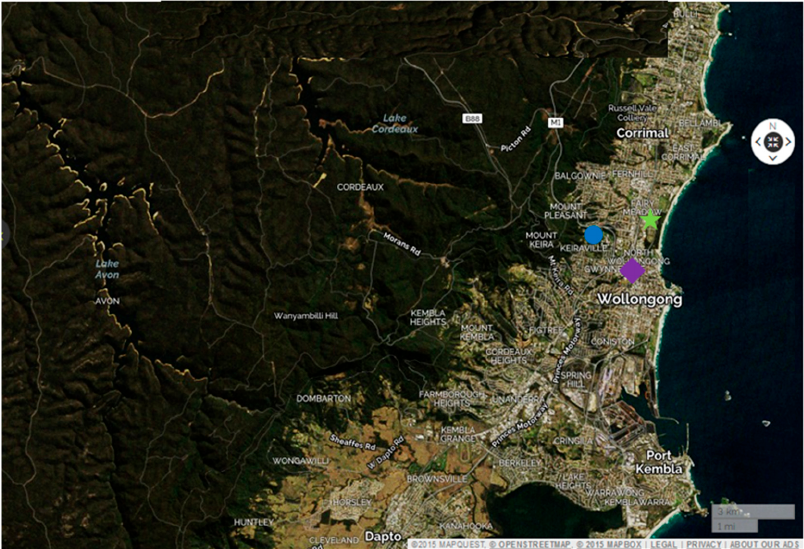
Figure 1. Satellite view of the region showing the main Measurements of Urban, Marine and Biogenic Air (MUMBA) site (green star), Wollongong Office of Environment and Heritage (OEH) Air Quality station (purple diamond) and the University of Wollongong (blue circle). Also visible is the large industrial area at Port Kembla and the extensive forested regions to the West. The image was created using the website: www.mapquest.com “© OpenStreetMap